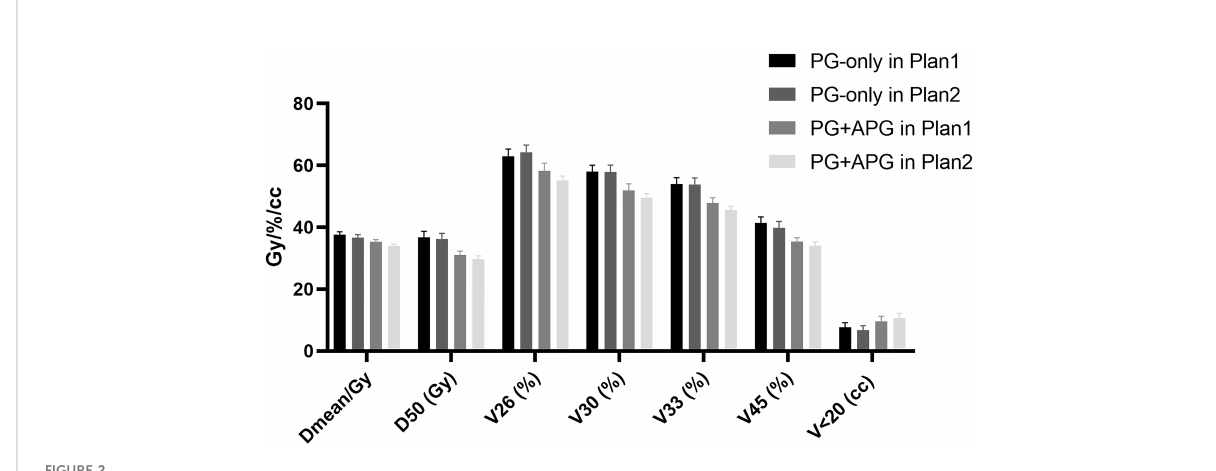
FIGURE 2 Dosimetric parameters in Plan1 and Plan2.